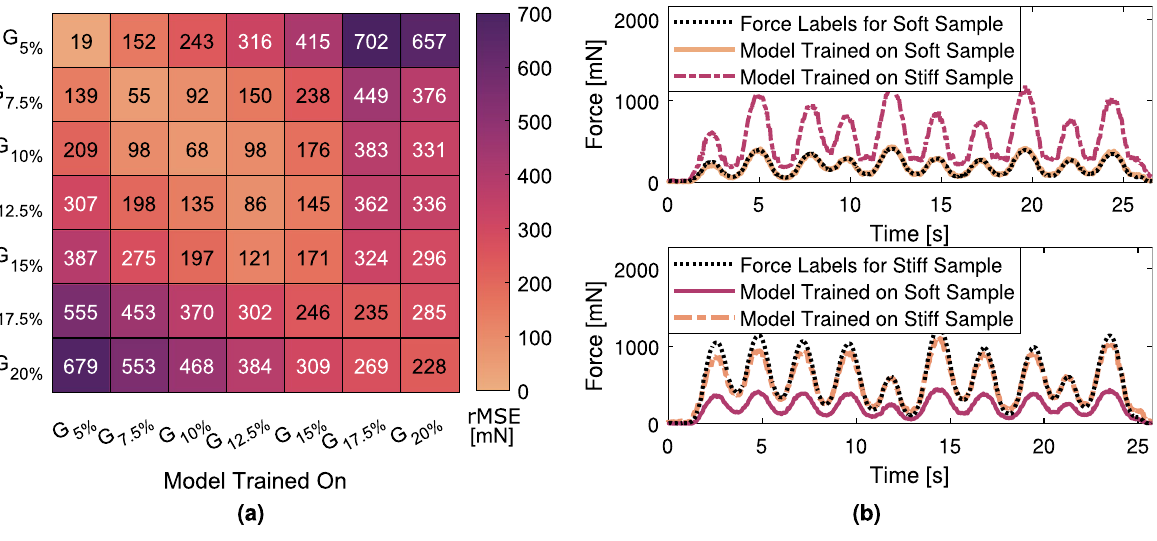
Figure 5. Force estimation: (a) Heatmap of the rMSE [mN] of all force estimates for individually trained models with 3D inputs V t . The x-axis denotes the gelatin gel on which the model is trained and the y-axis the gelatin gel used for evaluation. Better performance is given if the applied gelatin gel is similar to the training data. (b) Examples that display the impact of elasticity on force estimates when elasticity is not considered. A model trained on “stiff” samples ( G 17.5% ) applied on a “soft” material ( G 7.5% ) overestimates the applied forces due to the large deformations (top). Vice versa, forces are underestimated when transferring a model to stiffer materials (bottom). Line color is based on the rMSE and the colormap in (a).